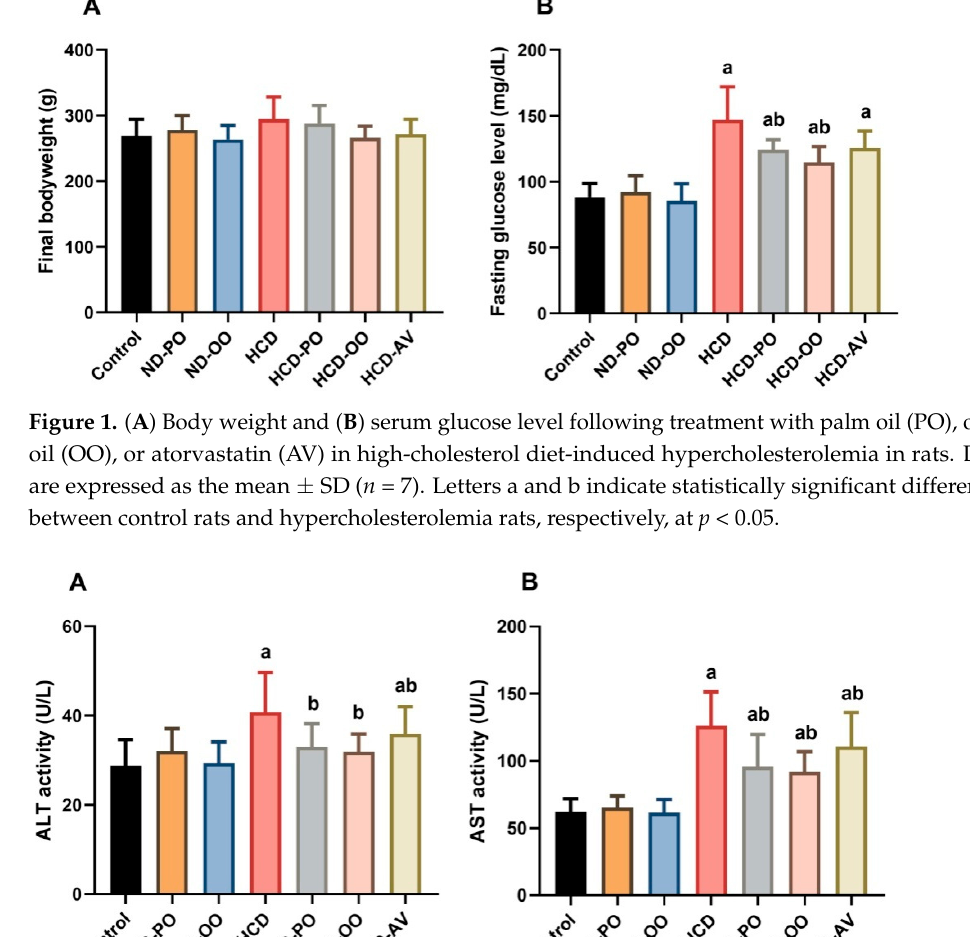
Figure 2. Serum transaminases (( A ) ALT and ( B ) AST) following treatment with palm oil (PO), ol- ive oil (OO), or atorvastatin (AV) in high-cholesterol diet-induced hypercholesterolemia in rats. Data are expressed as the mean ± SD ( n = 7). Letters a and b indicate statistically significant differ- ences between control rats and hypercholesterolemia rats, respectively, at p <0.05.